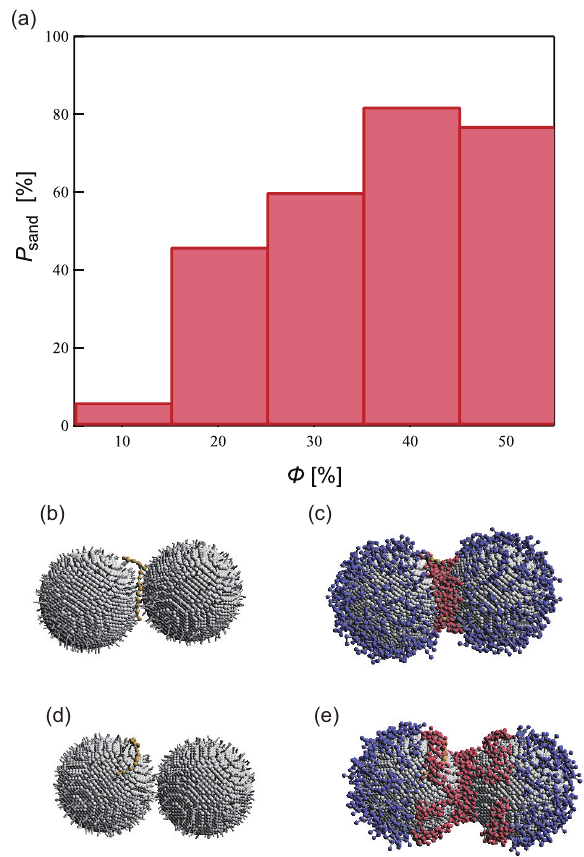
Figure 5. ( a ) Sandwiching probability of sensing the target at each coverage ratio for L = 3 and ρ = 0.8. ( b , d ) Snapshots of the PTNPs illustrating ( d ) effective and ( e ) ineffective ( φ = 50%) capture of the sensing target; ( c , e ) show the same snapshots with the grafted polymer particles, which were hidden in ( b , d ) for